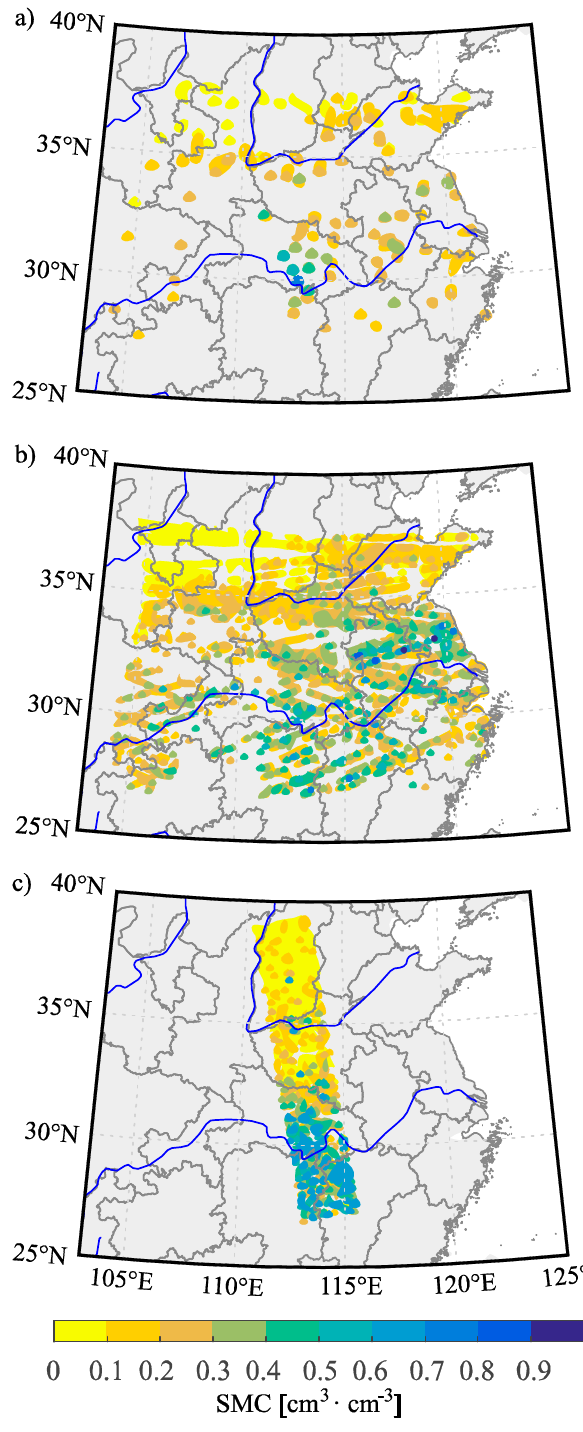
Figure 12. In ( a ) is shown SMC from CYGNSS for 1 April 2019, for θ < 40 ◦ and using SMAP VOD < 0.5 estimates from Figure 3 and ICESat-2 BSR estimates from Figure 2b. In ( b ) is shown SMC from CYGNSS for the same day, for θ < 40 ◦ and using SMAP VOD < 0.5 estimates from Figure 3 and SMAP BSR estimates from Figure 2a. In ( c ) is shown SMC from SMAP for the same day at 500-sample intervals.